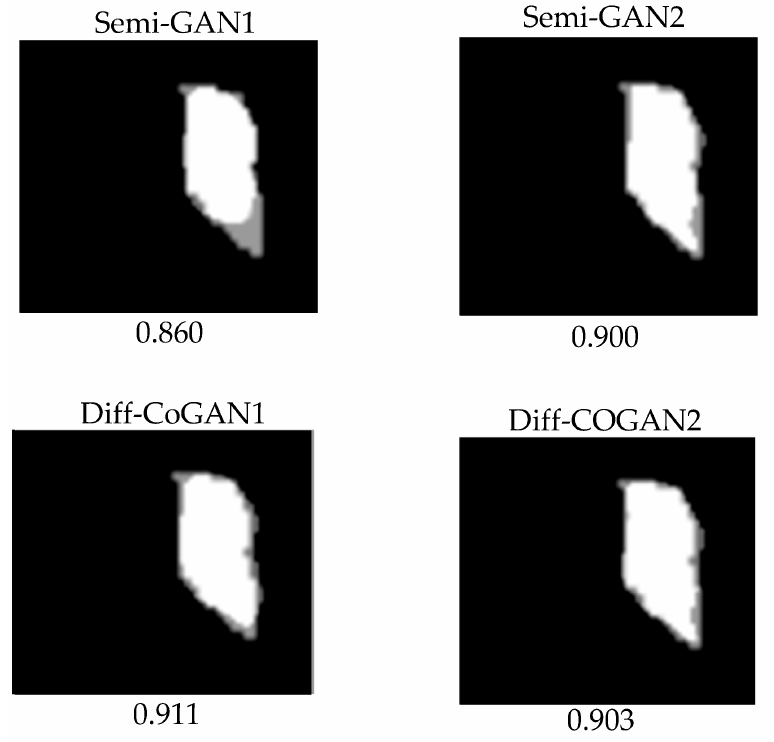
data points from the Hippocampus dataset are shown in Figure 8. The semi-supervised models and their corresponding Dice values are presented in each segmentation result. The segmented regions (in white) overlap the ground truth (in gray). The figure shows that the results of Diff-CoGAN are closer to the ground truth compared to semi-GAN.